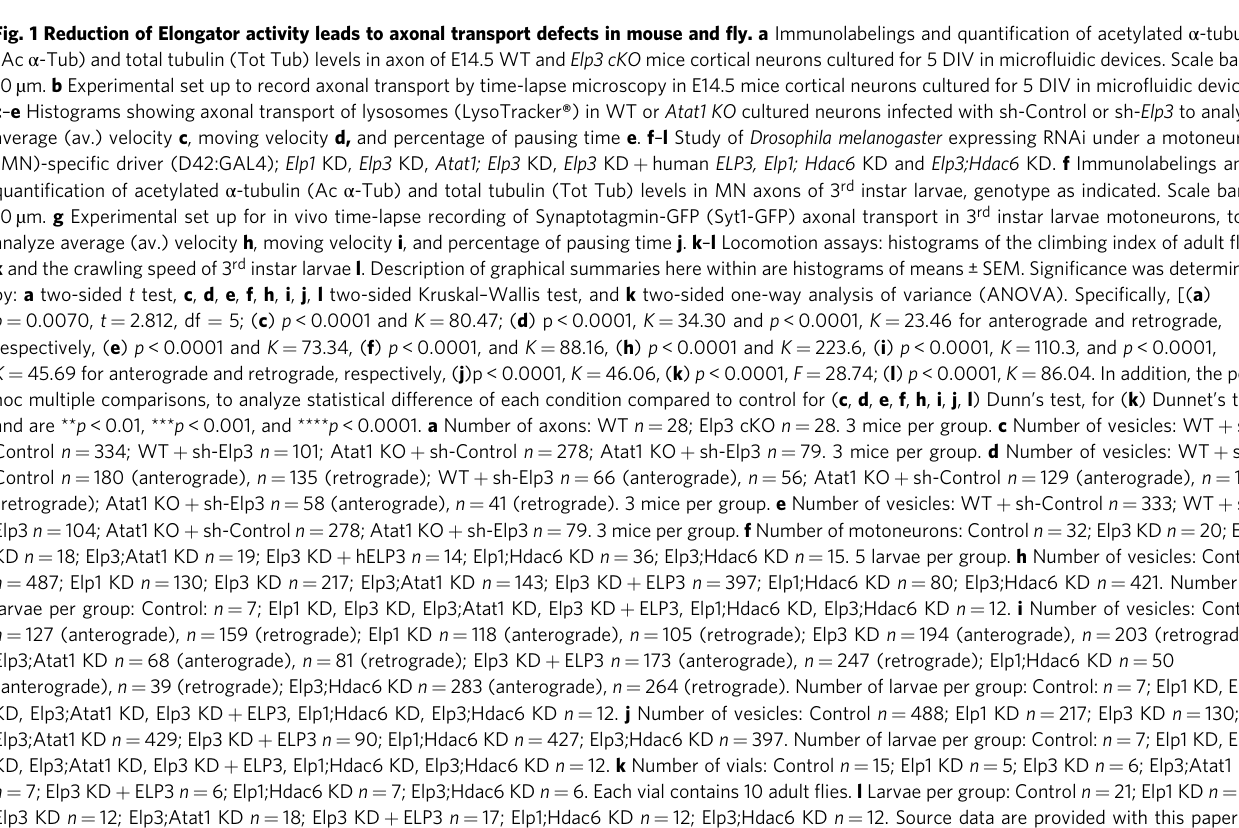
Fig. 1 Reduction of Elongator activity leads to axonal transport defects in mouse and fl y. a Immunolabelings and quanti fi cation of acetylated α -tubulin (Ac α -Tub) and total tubulin (Tot Tub) levels in axon of E14.5 WT and Elp3 cKO mice cortical neurons cultured for 5 DIV in micro fl uidic devices. Scale bar is 10 µ m. b Experimental set up to record axonal transport by time-lapse microscopy in E14.5 mice cortical neurons cultured for 5 DIV in micro fl uidic